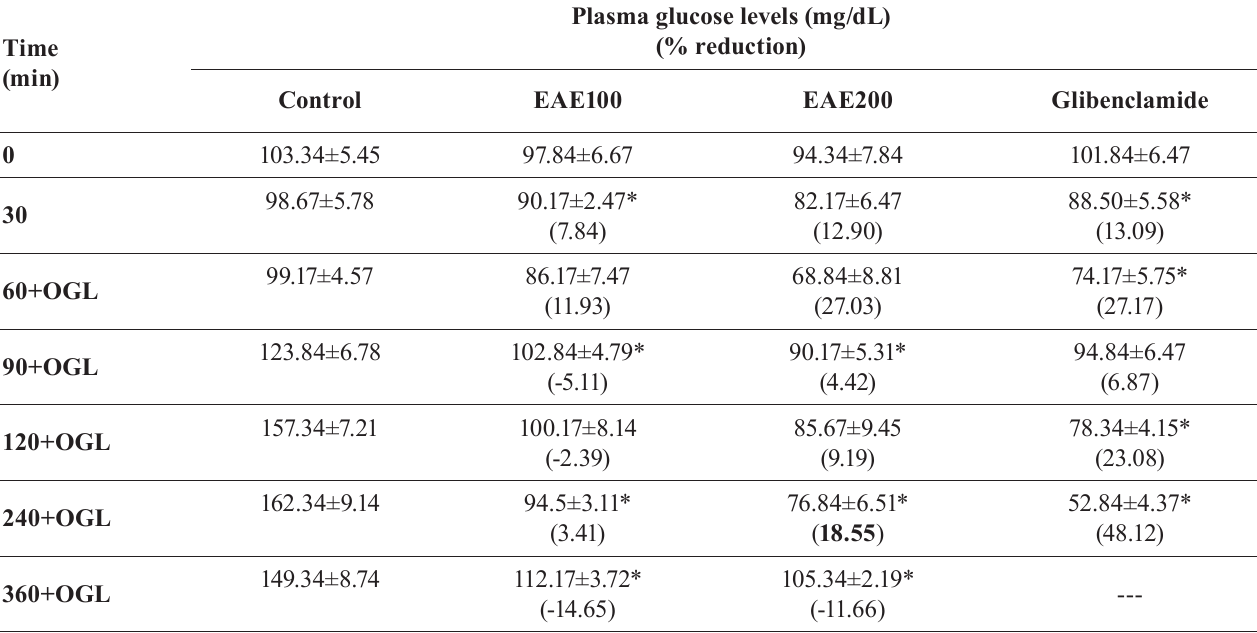
TABLE I – P lasma blood glucose levels in nomral and oral glucose loaded (OGL) rats due to effect of EAE at 100 and 200